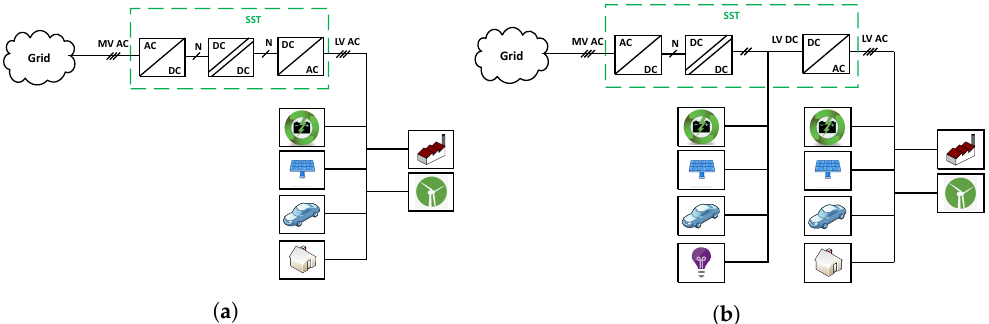
Figure 8. A SST controlling the point of common coupling in a typical microgrid system. This device adds intelligence to the MV/LV substation and provides new services and tools. ( a ) A SST supplying a single LV AC grid. ( b ) A SST supplying a hybrid AC/DC configuration.